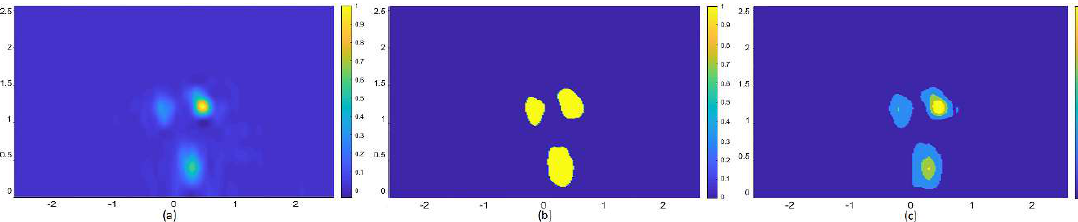
Figure 17. Segmented images of interference sources with different frequencies. ( a ) original image; ( b ) two thresholds segmentation; ( c ) three thresholds segmentation.